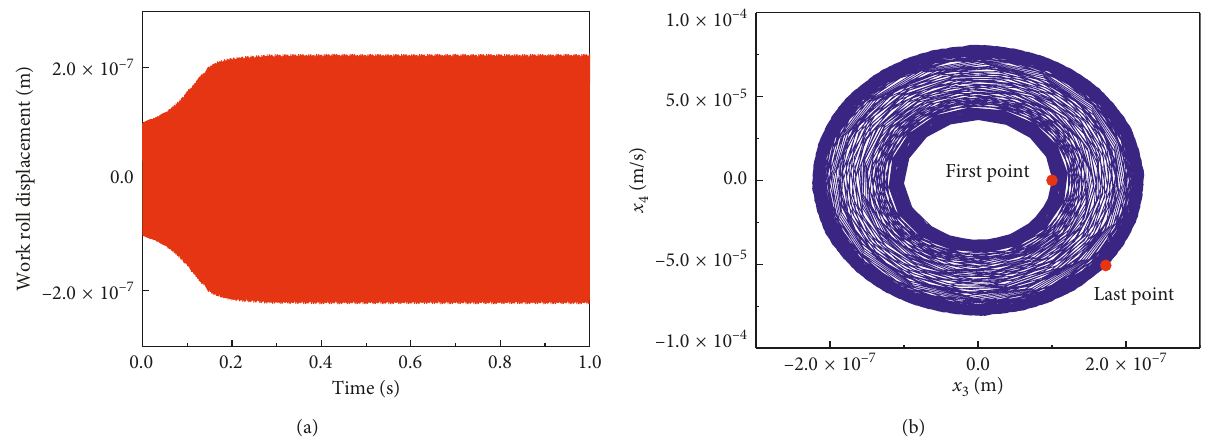
Figure 8: Dynamic response of the work roll displacement and the phase diagram under μ ∗ � 0 . 0401: (a) time history of work roll displacement; (b) phase diagram.